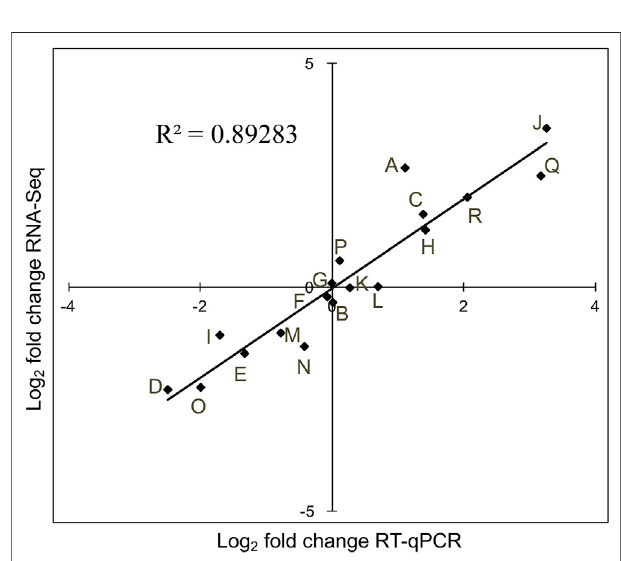
FIGURE 7 | Validation of DE-siRNAs using RT-qPCR. RNA-seq data ( Y -axis) were plotted against RT-qPCR log 2 -fold change values ( X -axis). Letters A to R represent siRNAs, being novel_sir966, novel_sir5526, novel_sir6288, novel_sir7548, novel_sir4946, novel_sir6523, novel_sir7091, novel_sir5666, novel_sir6315, novel_sir9784, novel_sir6347, novel_sir4575, novel_sir9463, novel_sir5161, novel_sir733, novel_sir8591, novel_sir3609, and novel_sir1979,